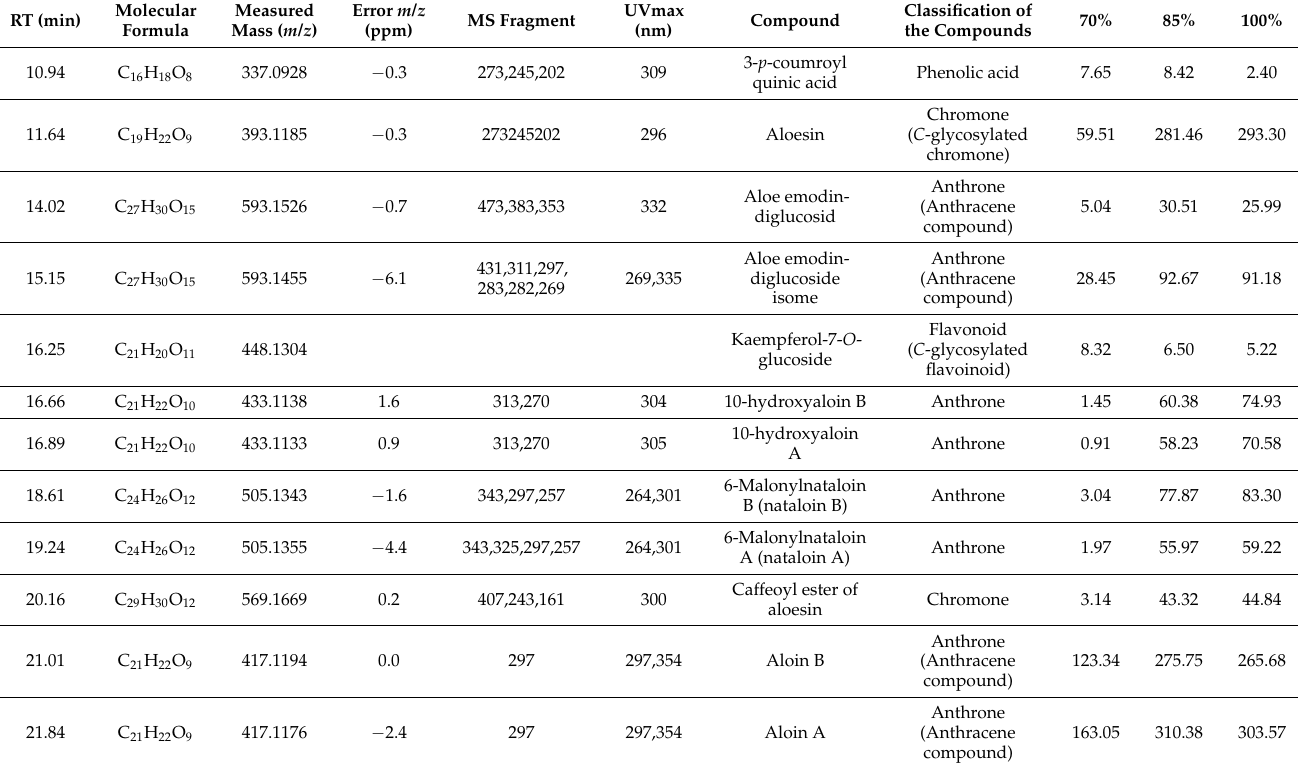
Table 2. Identification and mean abundance of the phytochemicals (mg L − 1 ) in Aloe vera extracts using 70%, 85%, and 100%